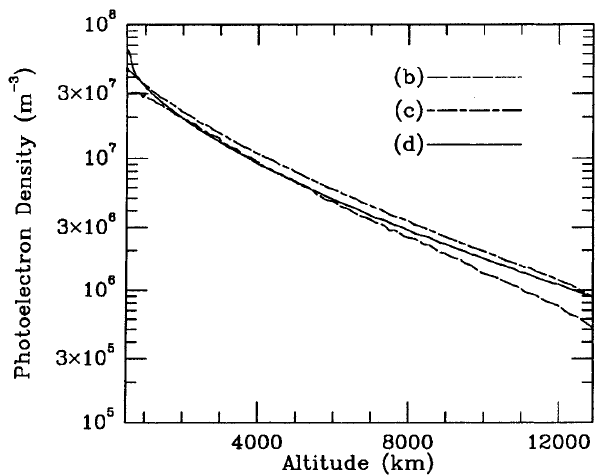
Fig. 14. Profiles of the photoelectron density. The labels correspond to the cases listed in Table 3